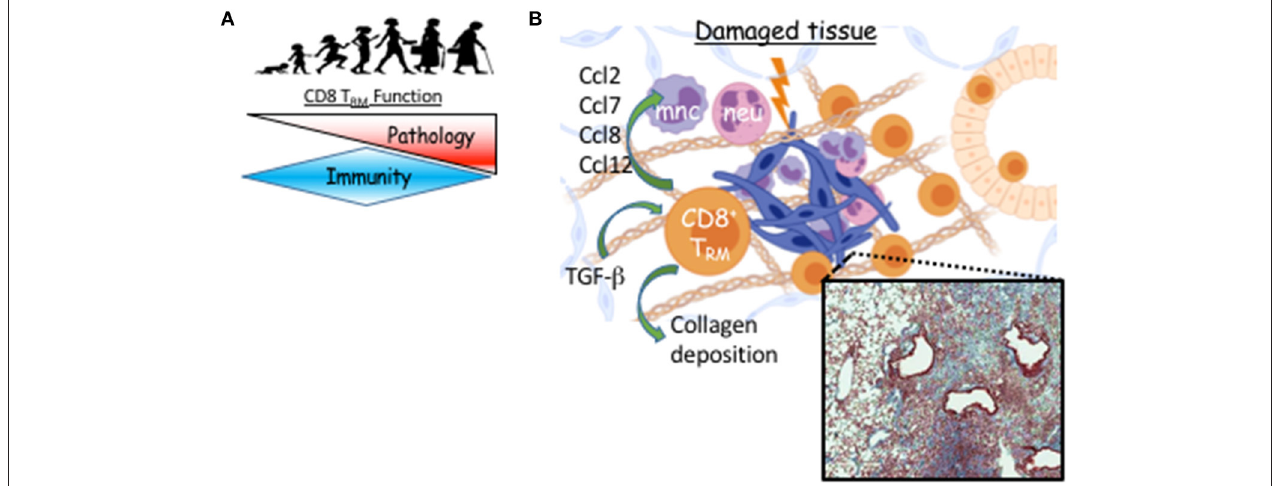
FIGURE 2 | T RM cell-mediated long-term sequelae post viral pneumonia during aging. (A) T RM function switches from immune protection to pathology as we age. (B) Following viral pneumonia, CD8 T RM cells accumulate in aged lungs where their differentiation is TGF-b–dependent. Instead of providing increased immune protection, they provoke pathology, likely through direct or indirect recruitment of myeloid cells that contribute to unresolved inflammation and prevention of collagen degradation. Micrograph is Masson’s trichrome stained lung from aged mouse 60 days post-H1N1 infection. Blue is digitally enhanced collagen deposition which is dependent on CD8 T RM cells (6). Created with